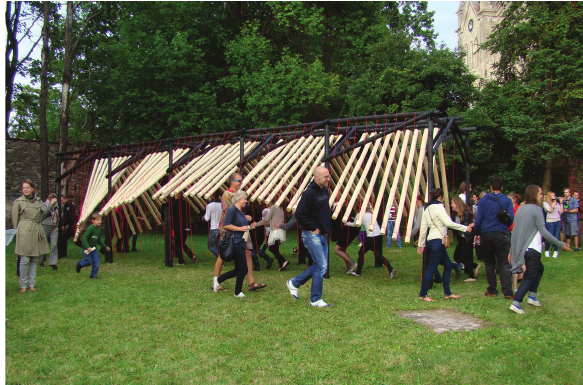
Figure 2. International Summer School 2013: